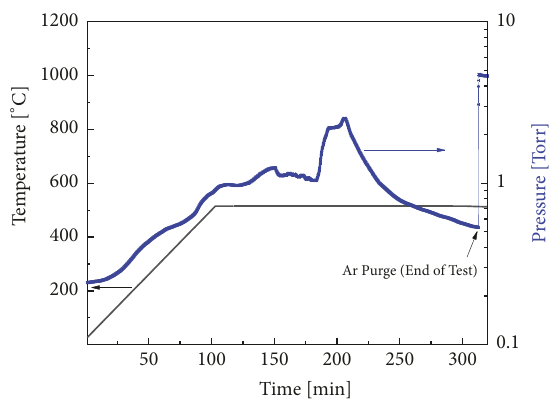
Figure 6: Temperature and pressure profiles as a function of time during Cd distillation